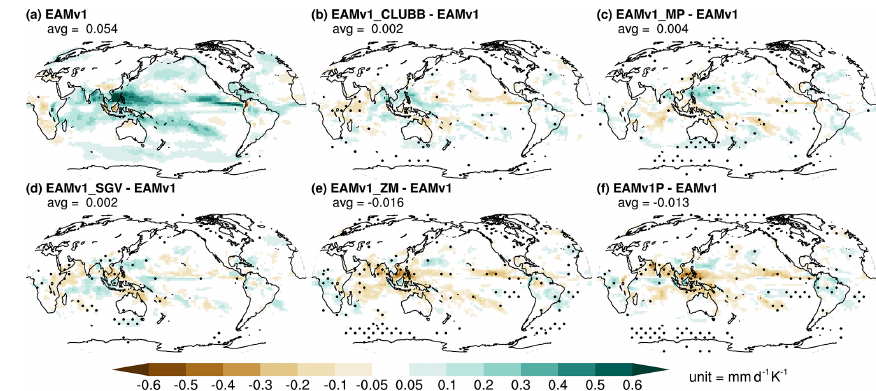
Figure 20. The change in convective precipitation rate induced by surface